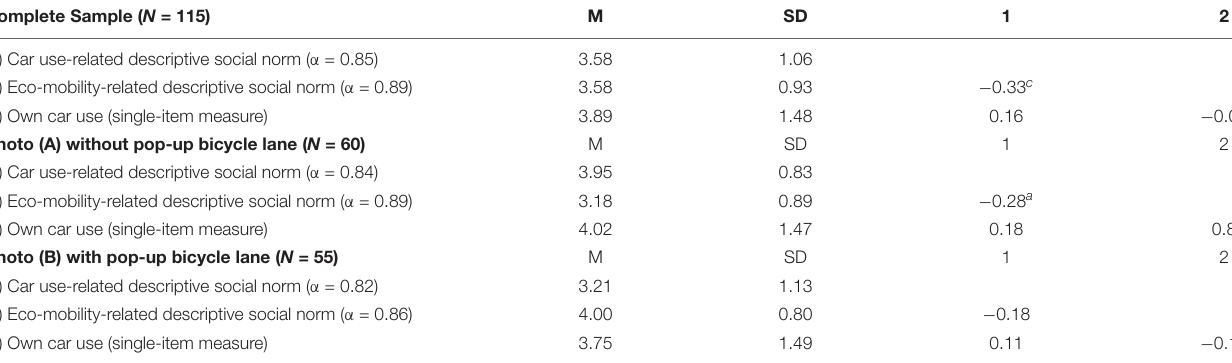
TABLE 3 | (Study 2) Labels, Cronbach’s α , means, SDs, and correlations of the descriptive norms and individual mobility behavior mean value indices ( N = 115). Complete Sample ( N =